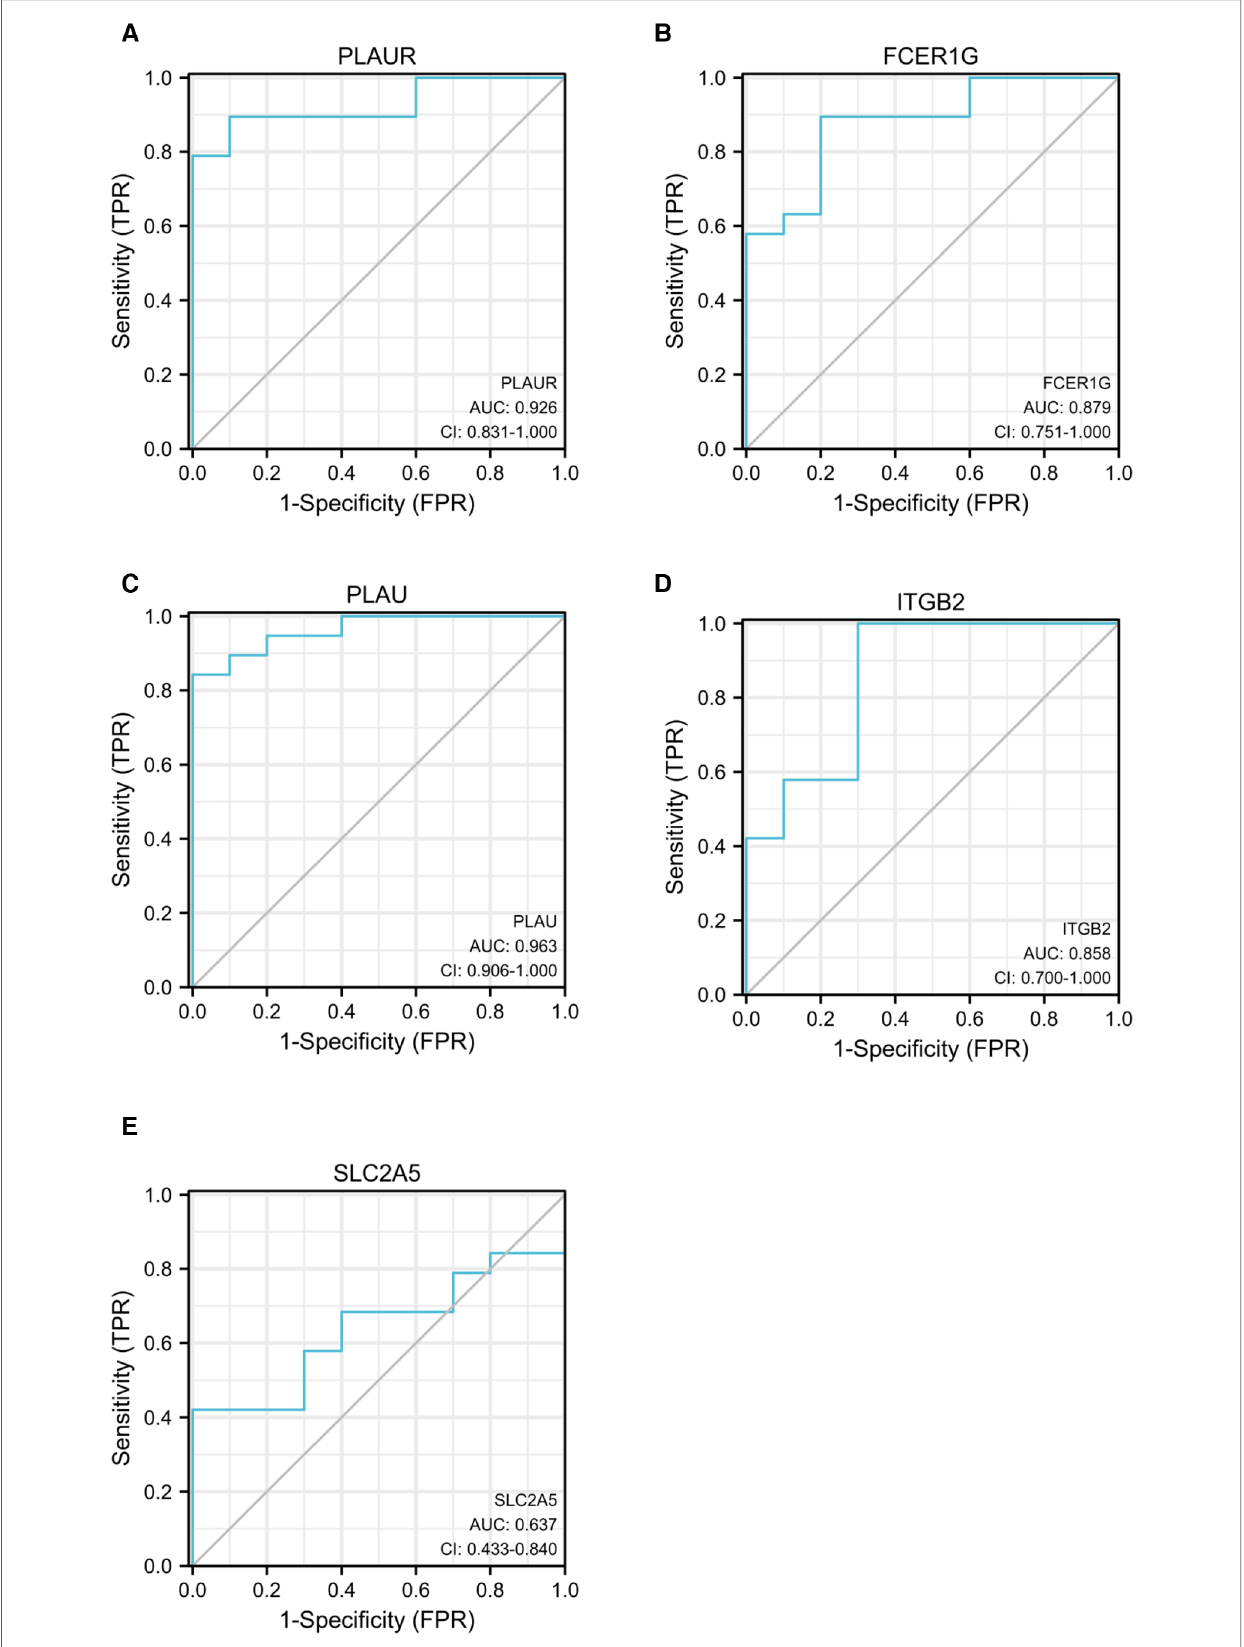
FIGURE 10 ROC curves for PLAUR ( A ), FCER1G ( B ), PLAU ( C ), ITGB2 ( D ), and SLC2A5 ( E ) to assess the capabilities of these genes to discriminate between patients with AP rupture and control group. ROC, receiver operating characteristic; APs, atherosclerotic